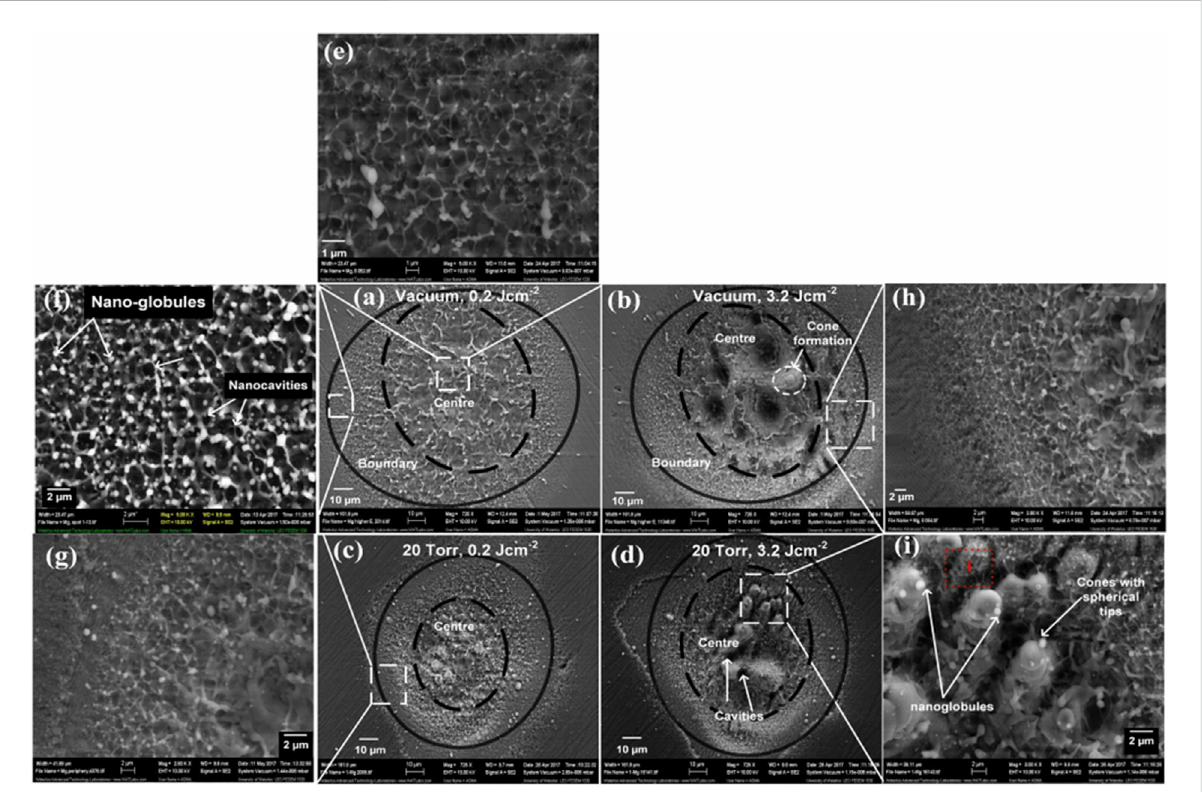
FIGURE 7 SEMmicrographsrevealingthesurfacemorphologyoftheablatedregionsofMgundervacuumatdifferent fl uence: (A) 0.2 J/cm 2 and (B) 3.2 J/ cm 2 and under an Ar pressure of 20 Torr at a fl uence of (C) 0.2 J/cm 2 (D) 3.2 J/cm 2 , (A – D) overall ablated area, (E,G,H) magni fi ed peripheral ablated areas (F) and (I) magni fi ed central ablated areas. (Hayat et al., 2019).